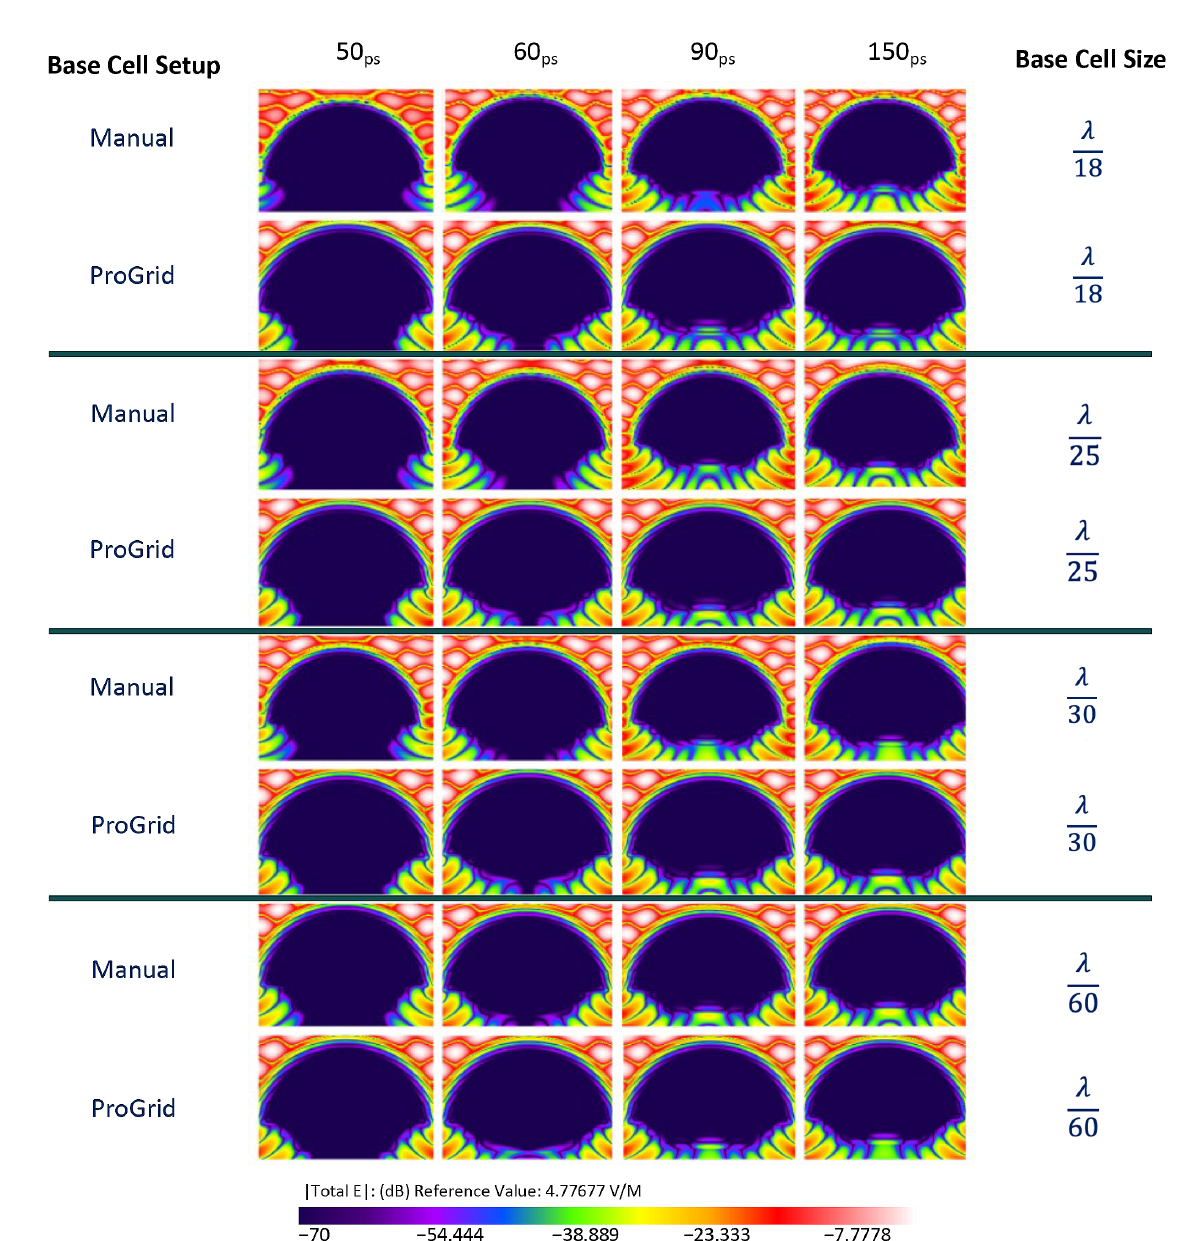
Figure 6. The output of planar E-field sensors for an EM source of 100GHz; the location of a planar E-field sensor placed vertically within the cornea. The simulation was carried out for λ /18 and λ /25, λ /30, and λ /60 using manual and PrOGrid setup.